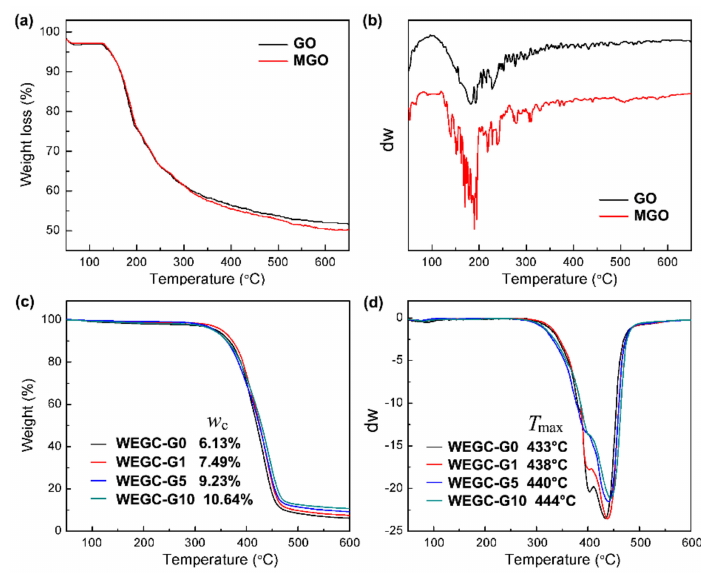
Figure 6. The thermogravimetric analysis (TGA) curves of ( a ) GO, MGO, and ( c ) WEGC; the derivative curve of TGA of ( b ) GO, MGO, and ( d ) WEGC.